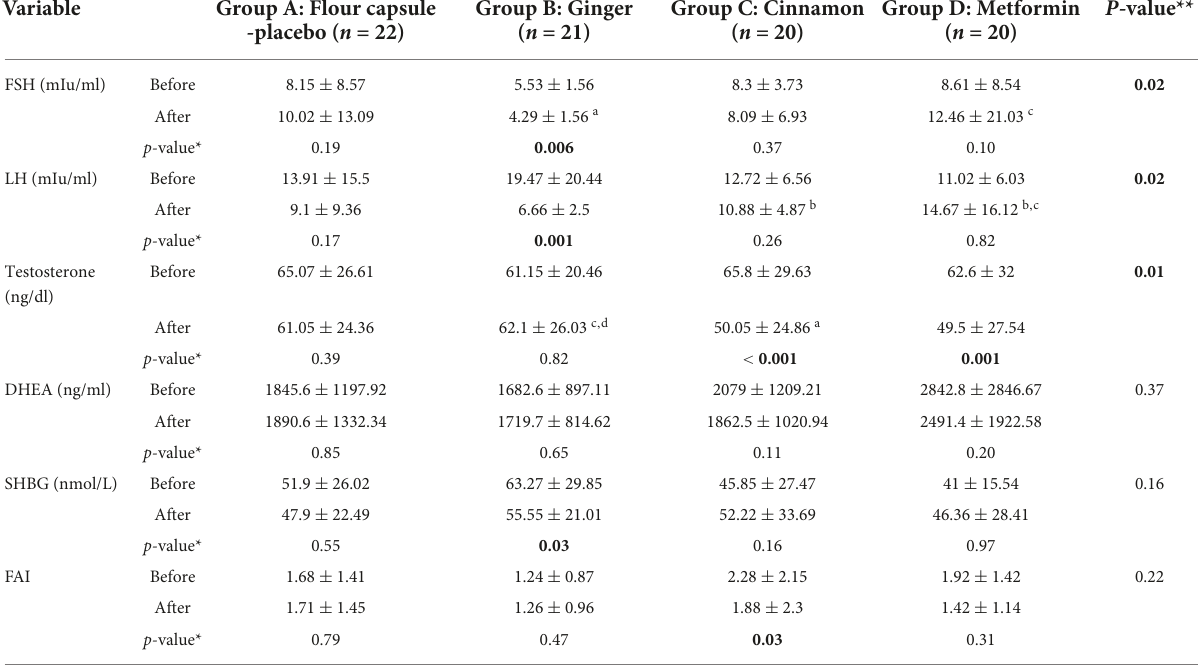
TABLE 3 Sexual hormones level of the patients before and after 8 weeks intervention. Variable Group A: Flour capsule